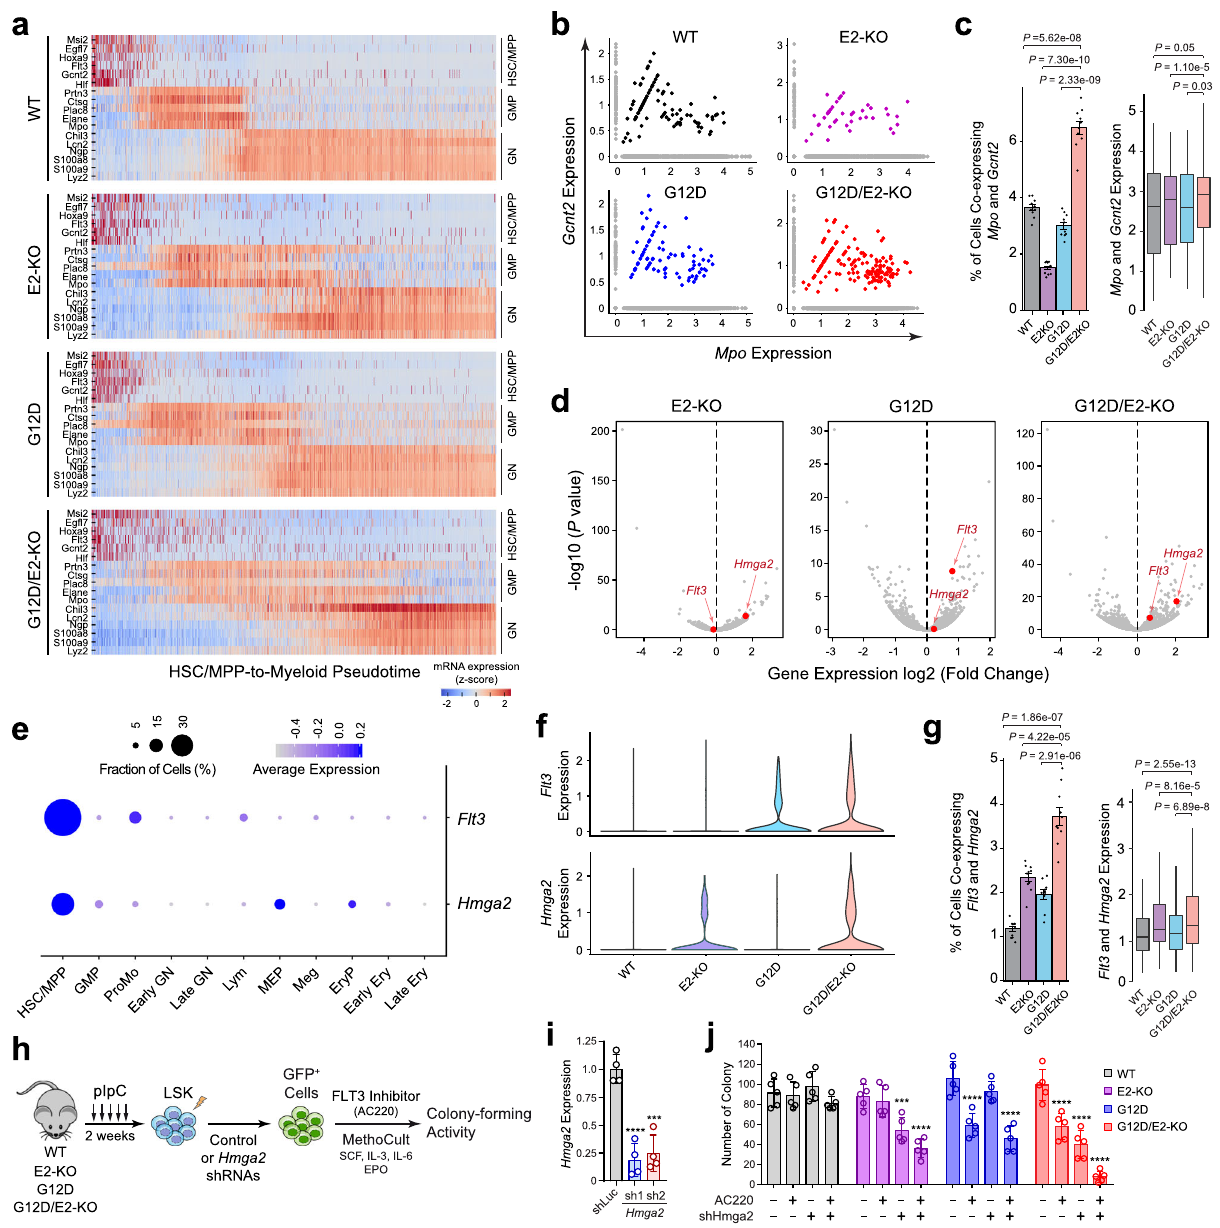
Fig. 4 Convergence of dysregulated transcriptional programs in single cells. a Expression of marker genes for HSC/MPP, GMP, and granulocytes (GN) along the HSC/MPP-to-myeloid differentiation pseudotime at T3. Heatmap shows normalized gene expression levels. b Scatter plots are shown for the expression of Gcnt2 and Mpo . Each dot represents a single cell. c Increased frequency of cells co-expressing Gcnt2 and Mpo in G12D/E2-KO HSPCs. Left graph shows the frequency of cells co-expressing Gcnt2 and Mpo . Results are mean ± SD of downsampling iterations ( N = 1000 cells for 10 iterations). Right graph shows the expression of Gcnt2 and Mpo in cells from different genotypes. Boxes show median of the data and quartiles, and whiskers extend up to 1.5× of the interquartile range. P values were calculated by a two-sided t test. d Volcano plots are shown for bulk RNA-seq. Hmga2 and Flt3 were upregulated in E2-KO and G12D HSPCs, respectively. Both Hmga2 and Flt3 were upregulated in G12D/E2-KO HSPCs. The x -axis shows the log2 fold changes of gene expression and the y -axis shows the negative log10 adjusted P values. e Dot plot shows the expression of Flt3 and Hmga2 . The size of the dot indicates the fraction of Flt3 or Hmga2 -expressing cells and the color indicates average mRNA levels. f Violin plots for Flt3 and Hmga2 expression. Flt3 - expressing HSC/MPP and ProMo cells and Hmga2 -expressing HSC/MPP and MEP cells were used. g Increased frequency of Flt3 and Hmga2 co-expressing cells in G12D/E2-KO HSPCs. The graphs were prepared as in panel c . h Experimental scheme to determine the effect of HMGA2 knockdown and/or FLT3 inhibition on colony-forming ability of HSPCs. i Knockdown of HMGA2 was validated by qRT-PCR. Results are mean ± SD ( N = 4 independent experiments) and analyzed by a one-way ANOVA. *** P < 0.001; **** P < 0.0001. j Combined HMGA2 depletion and FLT3 inhibition by AC220 led to more signi fi cant defects in colony-formation ability than individual treatments in G12D/E2-KO HSPCs. Results are mean ± SD ( N = 5 independent experiments) and analyzed by a two-way ANOVA. *** P < 0.001; **** P < 0.0001. Source data are provided as a Source Data fi